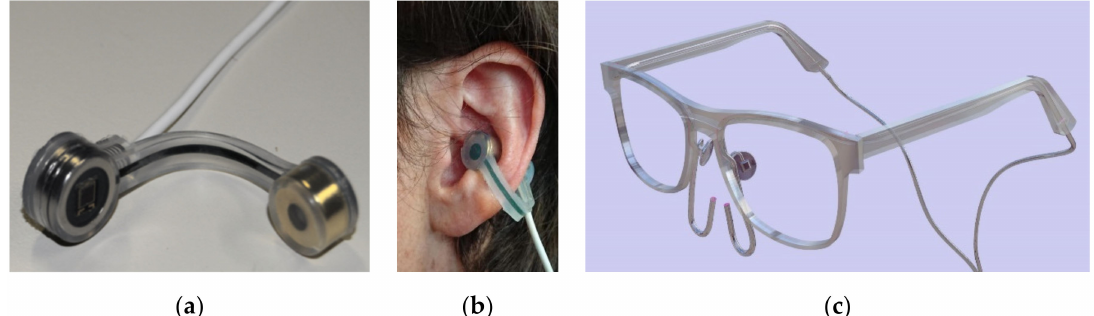
Figure 1. The sensor earpiece of the OxyFrame device in: ( a ) detached state showing the photodetector and the LEDs, and ( b ) attached at the cavum conchae of a volunteer’s ear holding together with statics magnets embedded in the sensor. ( c ) Prototype oxygen titration eyeglasses with integrated nasal oxygen cannulas (only for illustration of the future